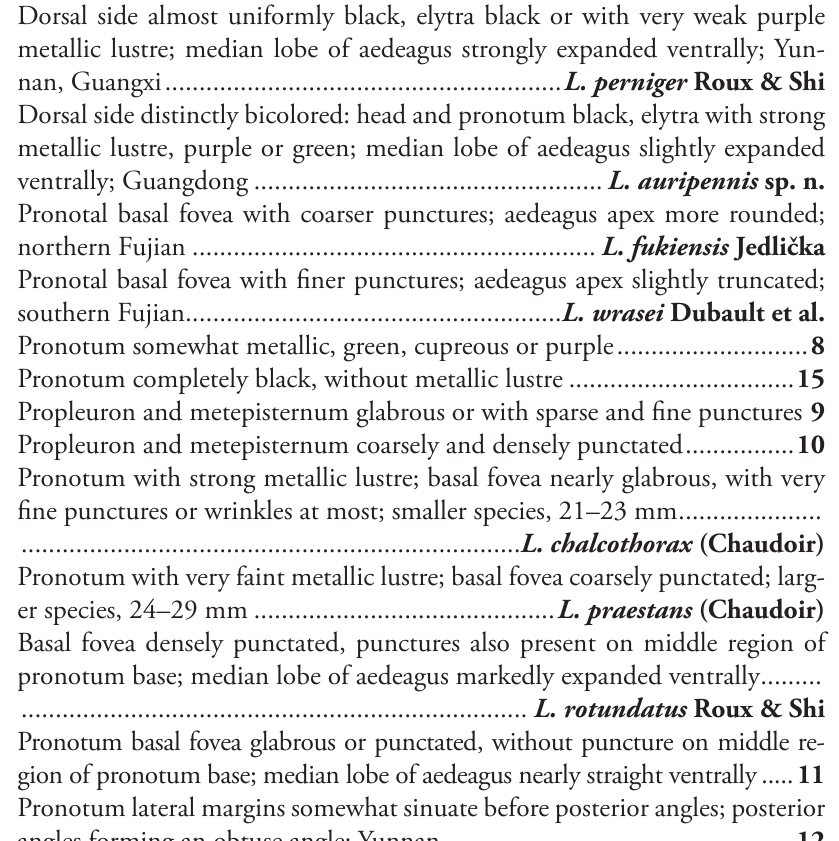
Dorsal side distinctly bicolored: head and pronotum black, elytra with